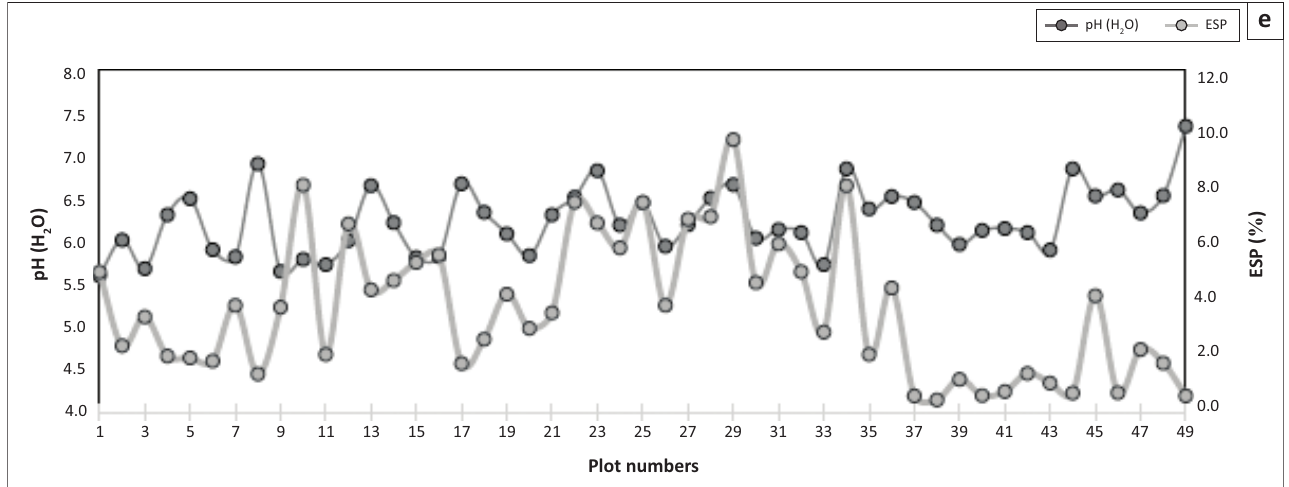
FIGURE 3 (Continues...): Profile of average physical and chemical properties along the catena. (a) Topography/elevation of the catena, (b) particle size distribution, (c) basic cations, (d) selected cation to clay ratios and (e) pH and exchangeable sodium